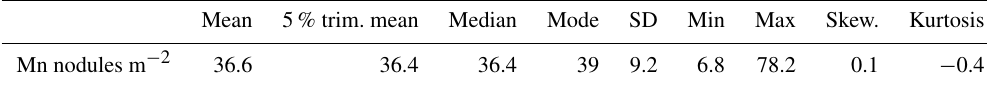
Table B6. The descriptive statistics of the number of Mn nodules m − 2 .